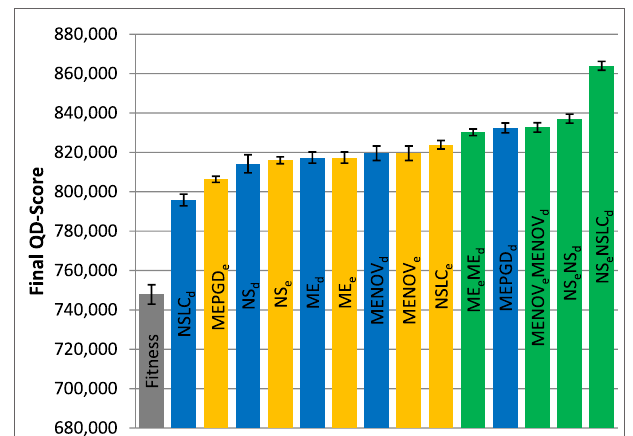
FigUre 6 | Final QD-score (small maze) . The QD-score achieved by each of fifteen treatments ( Table 2 ) after 250,000 evaluations on the small maze is shown (averaged over 20 runs). Bars are color coded according to which BC drives search (see section 6) and error bars represent SE. In all cases, QD-score is measured with respect to DirectionBC. The maximum possible QD-score on the small maze is 1,024,000 corresponding to a perfect solution in all 1,024